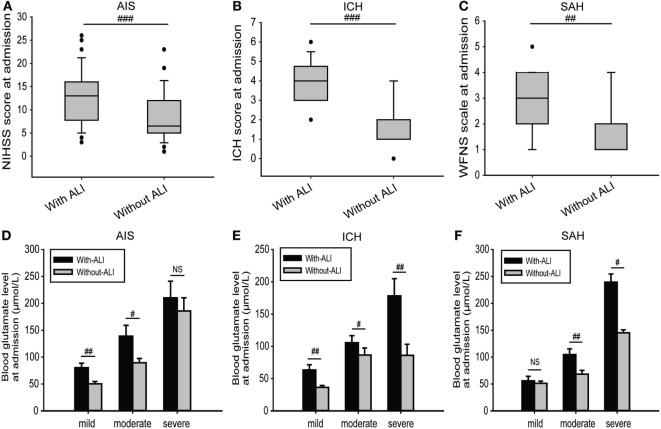
Comparisons of severity scores and blood glutamate levels at admission between patients with and those without ALI. (A–C) Comparison of severity scores at admission for patients in different subgroups and with or without ALI. (D–F) Comparison of blood glutamate levels at admission between different severities in patients with AIS, ICH, or SAH. Data are expressed as the median (IQR) (A–C) and means (SE) (D–F). #p < 0.05, ##p < 0.01, and ###p < 0.001 by two-tailed Student’s t-tests or non-parametric Mann–Whitney U tests; NS, no significance. Abbreviations: AIS, acute ischemic stroke; ICH, intracerebral hemorrhage; NIHSS, National Institutes of Health Stroke Scale; SAH, spontaneous subarachnoid hemorrhage; WFNS, World Federation of Neurosurgical Surgeons; ALI, acute lung injury; IQR, interquartile range.